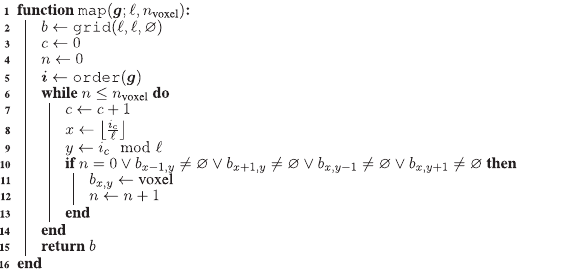
Algorithm 1: The algorithm for mapping a genotype g ∈ R ℓ 2 to a morphology b of n voxel voxels enclosed in a ℓ × ℓ grid.